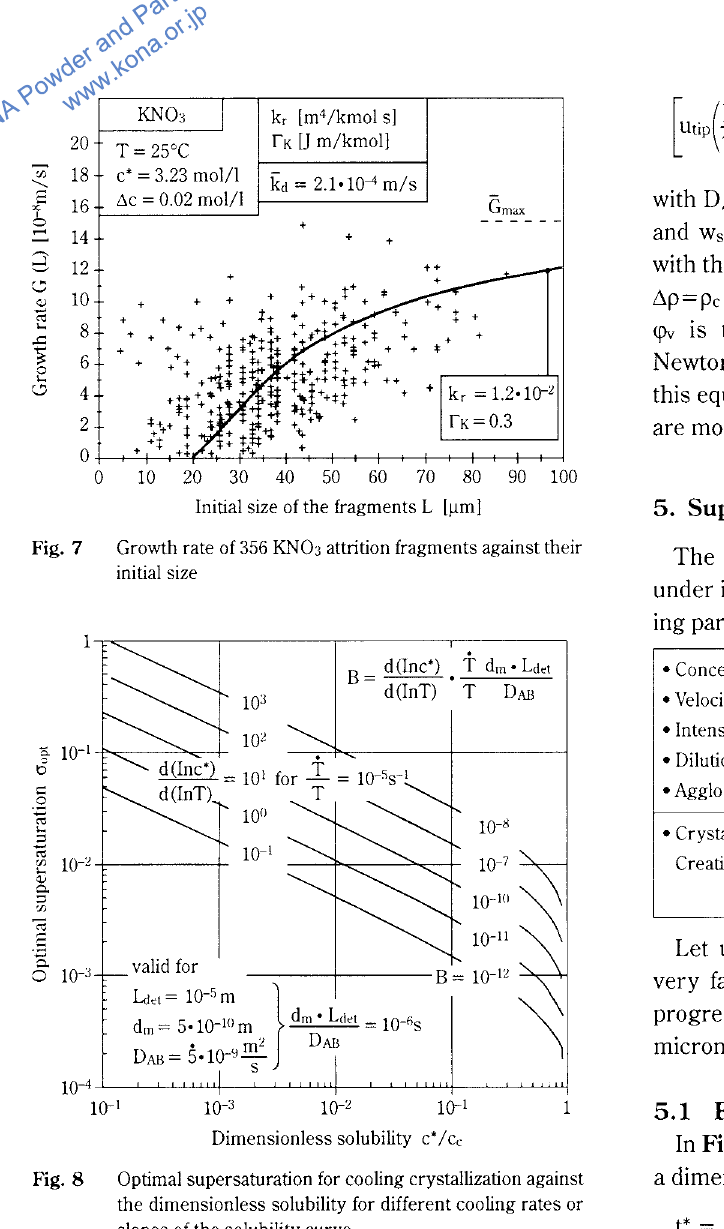
Optimal supersaturation for cooling crystallization against the dimensionless solubility for different cooling rates or slopes of the solubility curve mation, the growth rate differs from fragment to frag ment (Growth Rate Dispersion, GRD). As a result